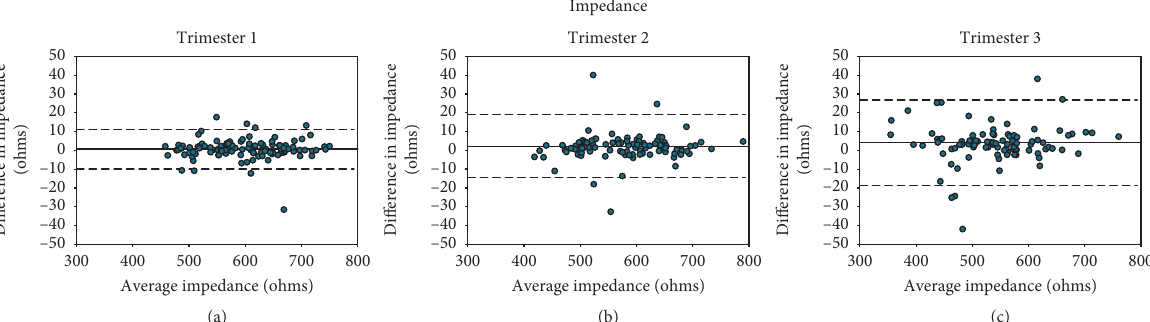
Figure 3: Bland–Altman plots of the differences of impedance against average impedance between two methods, Bodystat and RJL, in (a) T1, (b) T2, and (c)